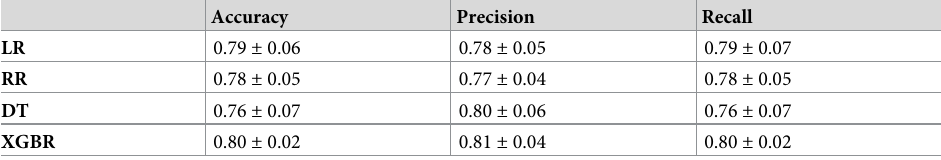
Table 6. Weighted average scores for future propensity predictions.